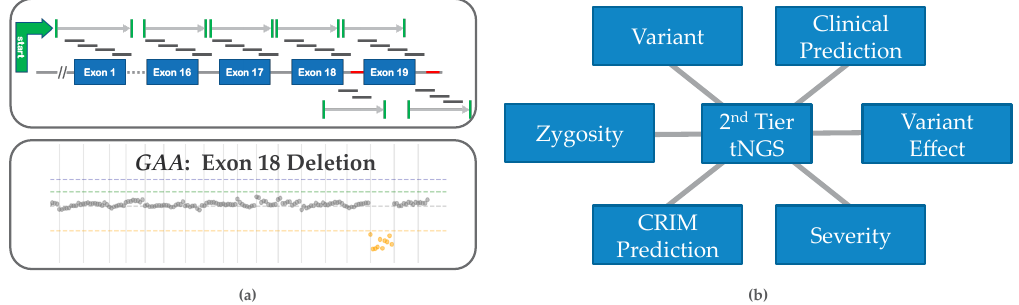
Figure 2. Second tier Testing features: ( a ) Top panel shows how GAA gene structure is targeted for sequencing with overlapping single stranded DNA or RNA probes of 60–200 nucleotides in target exonic regions (blue rectangles), adjoining splice junctions (marked in green), and known hotspots (red). The bottom panel shows the results of a in-house algorithm that integrates detection of copy number variation (CNV) or del / dup events in Pompe disease, such as the GAA exon 18 deletion; ( b ) 2nd tier tNGS provides variant (genotype) information for better clinical predictions and management of care. Pseudodeficient alleles, variant e ff ect, and cross-reactive immunologic material (CRIM) prediction can be elucidated from previously observed data